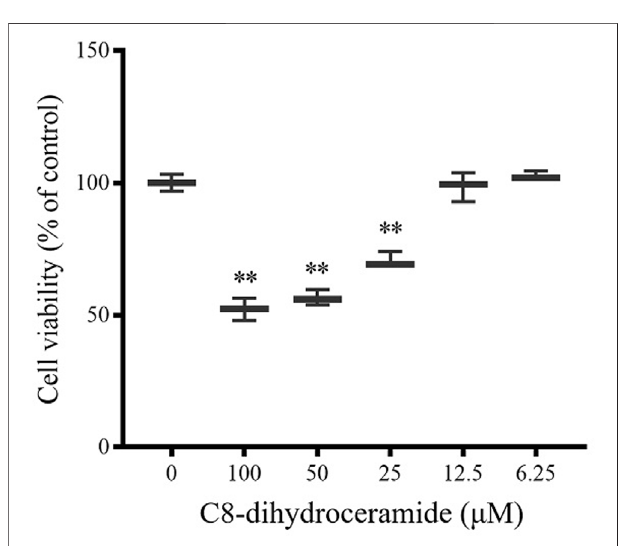
FIGURE 6 | The viability of WISH cells was inhibited by C8- dihydroceramide. WISH cell lines seeded on 96-well plates were treated with C8-dihydroceramide (0, 6.25, 12.5, 25, 50, or 100 μ M) for 24 h. Bars represent the mean values with min to max intervals. ** p <